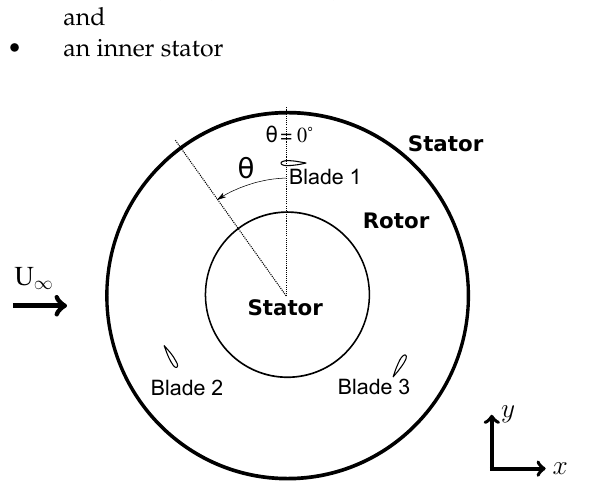
Figure 3. Computational domain.